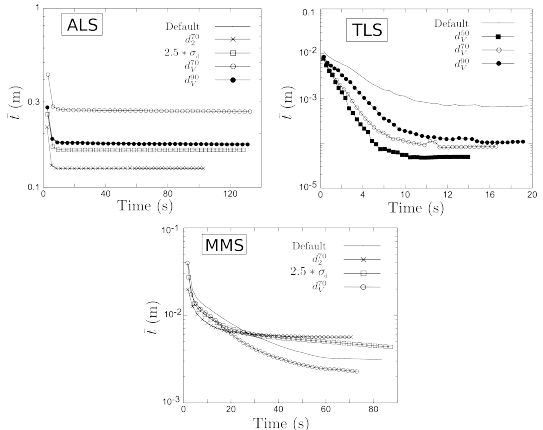
Figure 7: Rejecting step results.